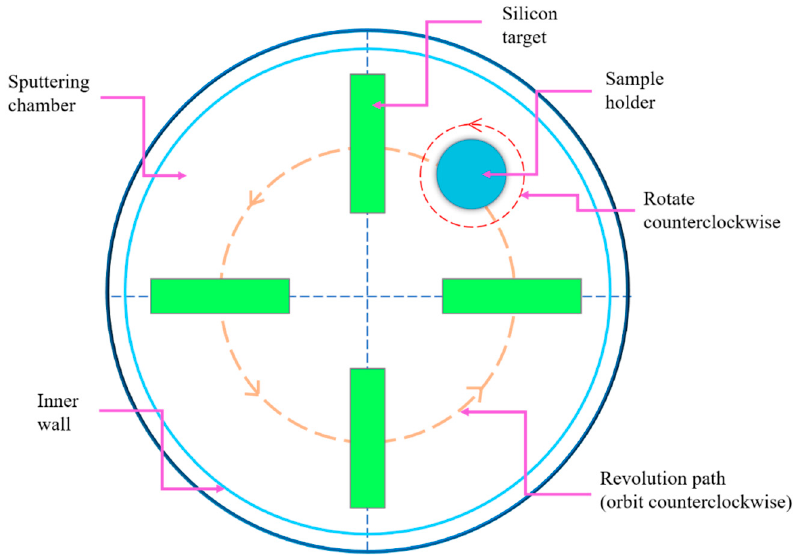
Figure 4. Planetary motion magnetron sputtering coating system.